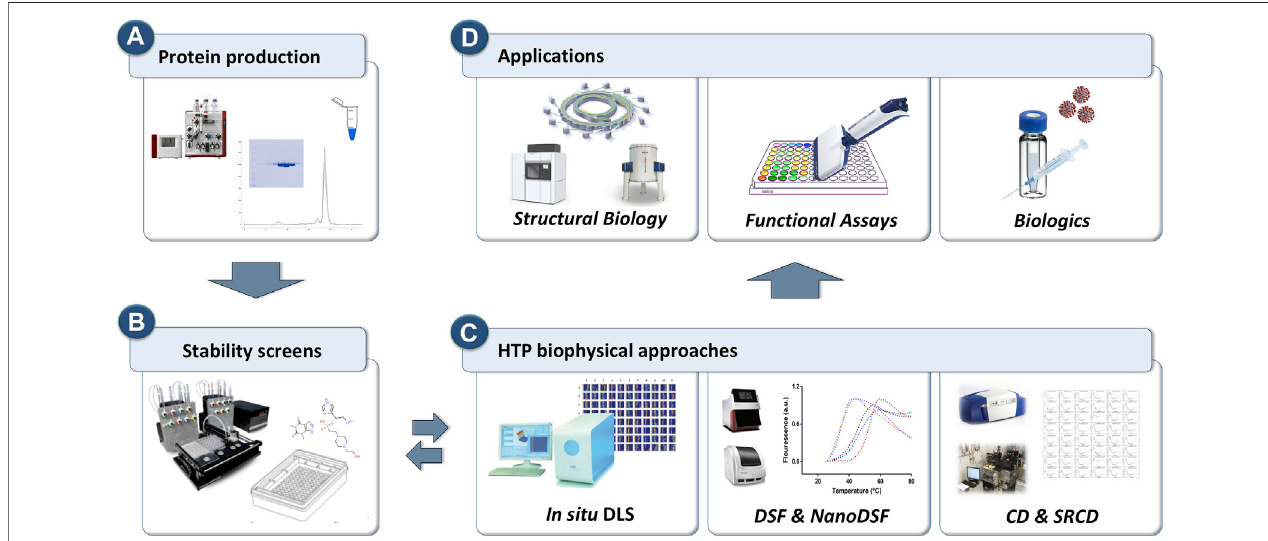
FIGURE 1 | Schematic representation of the work fl ow for the HTP biophysical approaches to probe protein behavior for downstream and upstream applications. (A) Proteins are puri fi ed using standard puri fi cation strategies. (B) HTP screens are prepared to explore chemical space. (C) in situ Dynamic Light Scattering (DLS), differential scanning fl uorimetry (DSF) and circular dichroism (CD) that can operate in HTP mode are used as primary screening tools to probe protein stability. (D) Three key applications where protein monodispersity and stability is crucial.